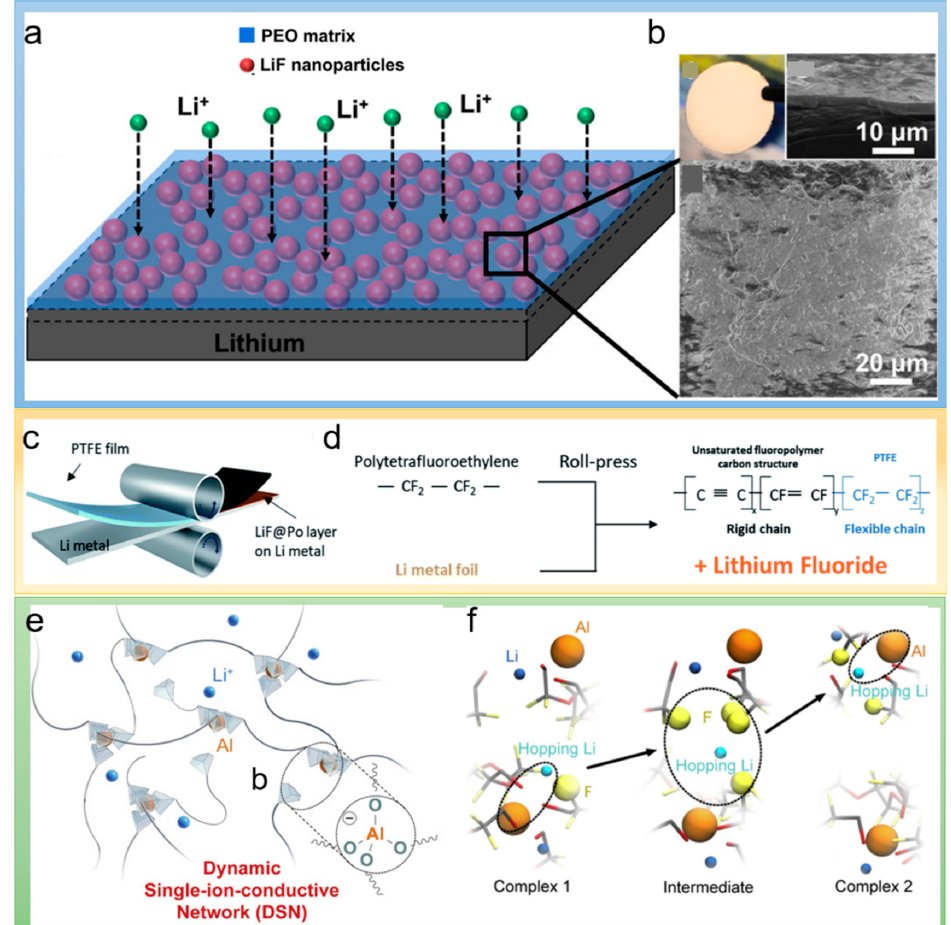
Figure 4. ( a ) Scheme of the LiF/PEO composite coating on lithium metal. ( b ) Photograph of the lith- ium metal electrode coated with the LiF/PEO composite; top view and cross-sectional SEM images of the LiF/PEO composite coating [48]. Reproduced with permission. Copyright 2020, American Chemical Society. ( c ) Schematic illustration of the LiF or LiF@Po protection layer formation on the Li metal by the roll pressing process between Li metal and the PTFE film. ( d ) Chemical reaction model during the roll pressing process. Reproduced with permission [49]. Copyright 2020, Royal Chemical Society. ( e ) Schematic diagram of the molecular structure of the dynamic single-ion con- ducting network (DSN). ( f ) Li + ion transport pathway. The hopping Li + ion is shown in light blue yellow spheres. For clarity, FTEG chains are faded [50]. Reproduced with permission.